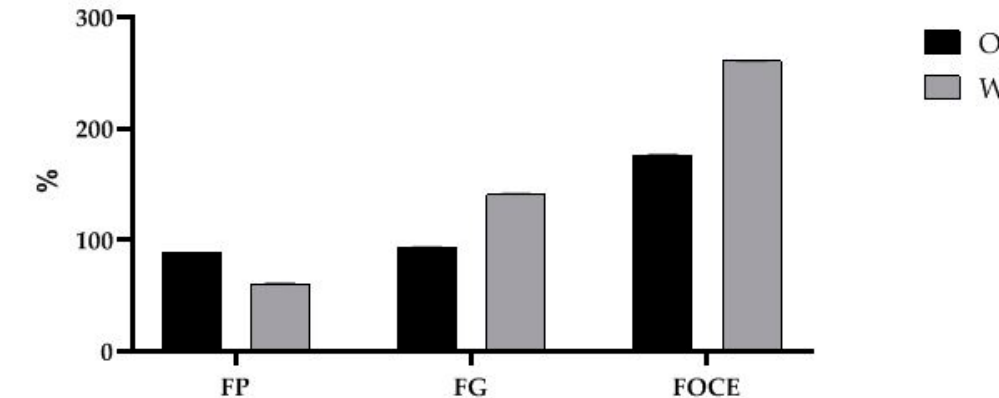
Figure 2. Water Holding Capacity and Oil Binding Capacity of FG, FP and FOCE. FG—flaxseed gum